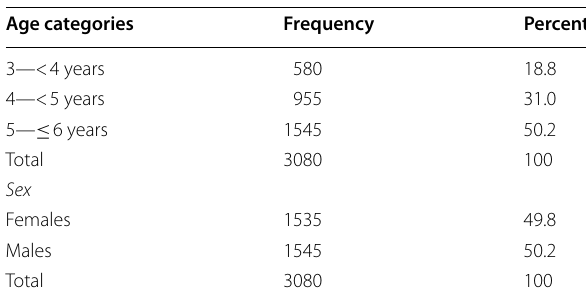
Table 1 Data of Age and sex of the studied